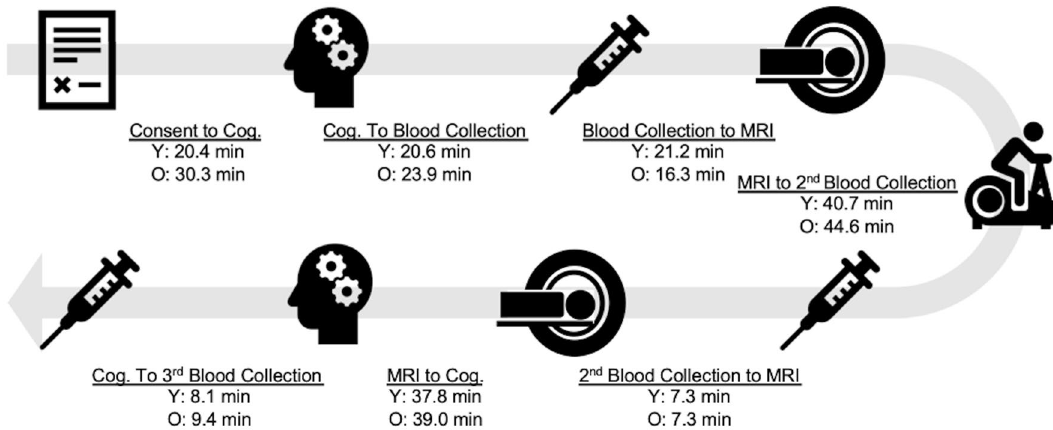
Figure 2. Study flow and average time for each study event.